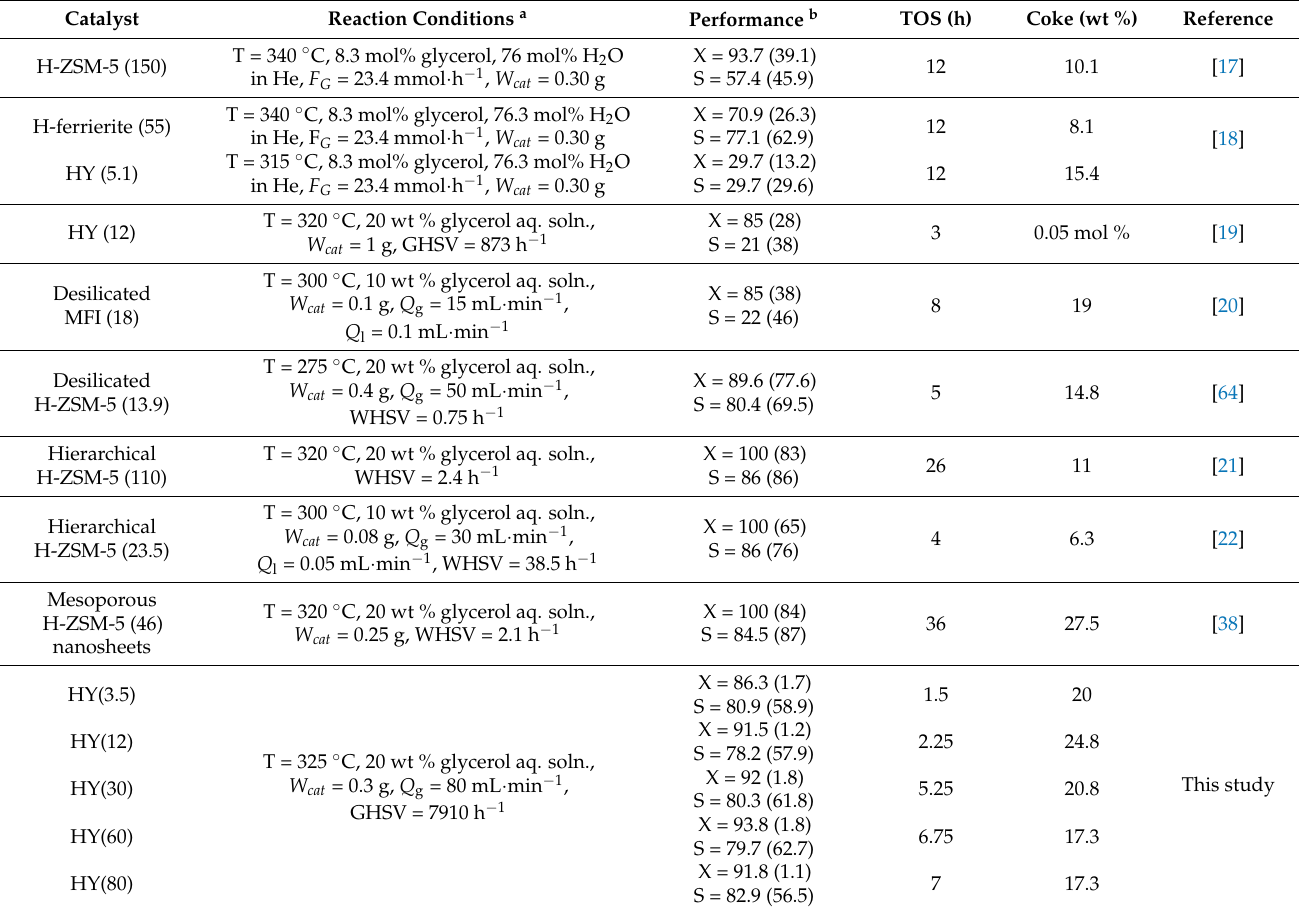
Table 5. Catalytic performance and deactivation during the glycerol dehydration over different zeolite catalysts.